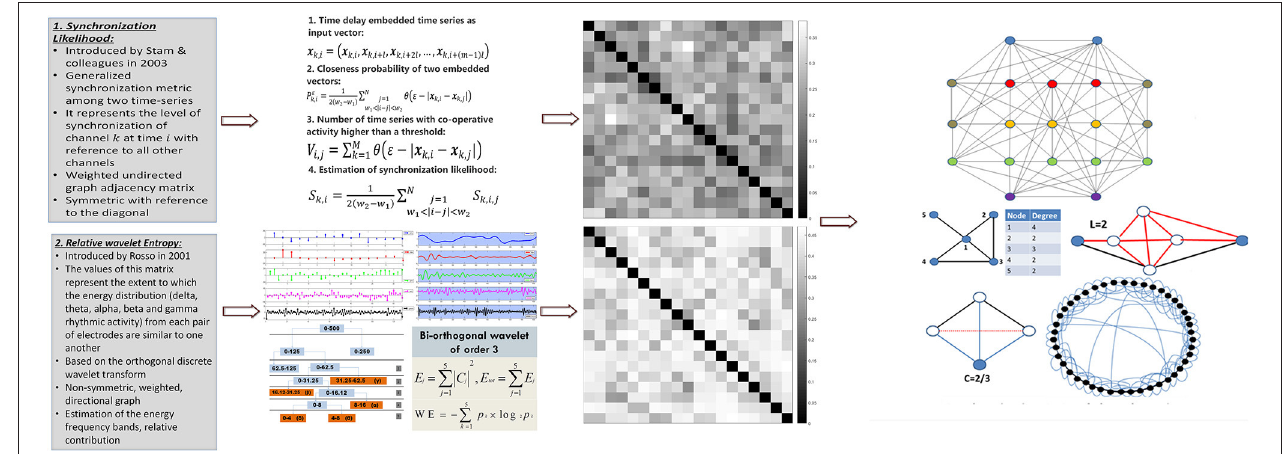
FIGURE 2 | Feature extraction: For each epoch, the feature extraction procedure takes place during which features that quantify the macroscopic organization of the brain during sleep are extracted. Two alternative functional connectivity methodologies (Synchronization Likelihood and Relative Wavelet Entropy) are investigated. The synchronization matrices are used through concepts derived from graph theory (small-world property, cluster coefficient, characteristic path length, betweenness centrality, node degree) to form the feature vectors used for the computerized